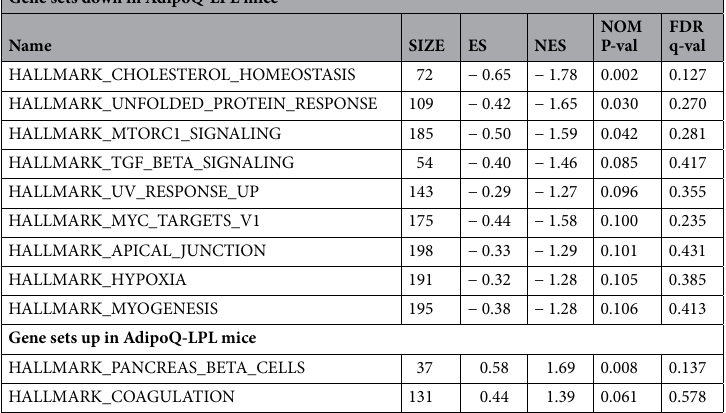
mice (Table S1). Thus, key genes in lipid and cholesterol biosynthesis are repressed in AdipoQ-LPL mice, con- sistent with increased expression of LPL by the transgene.